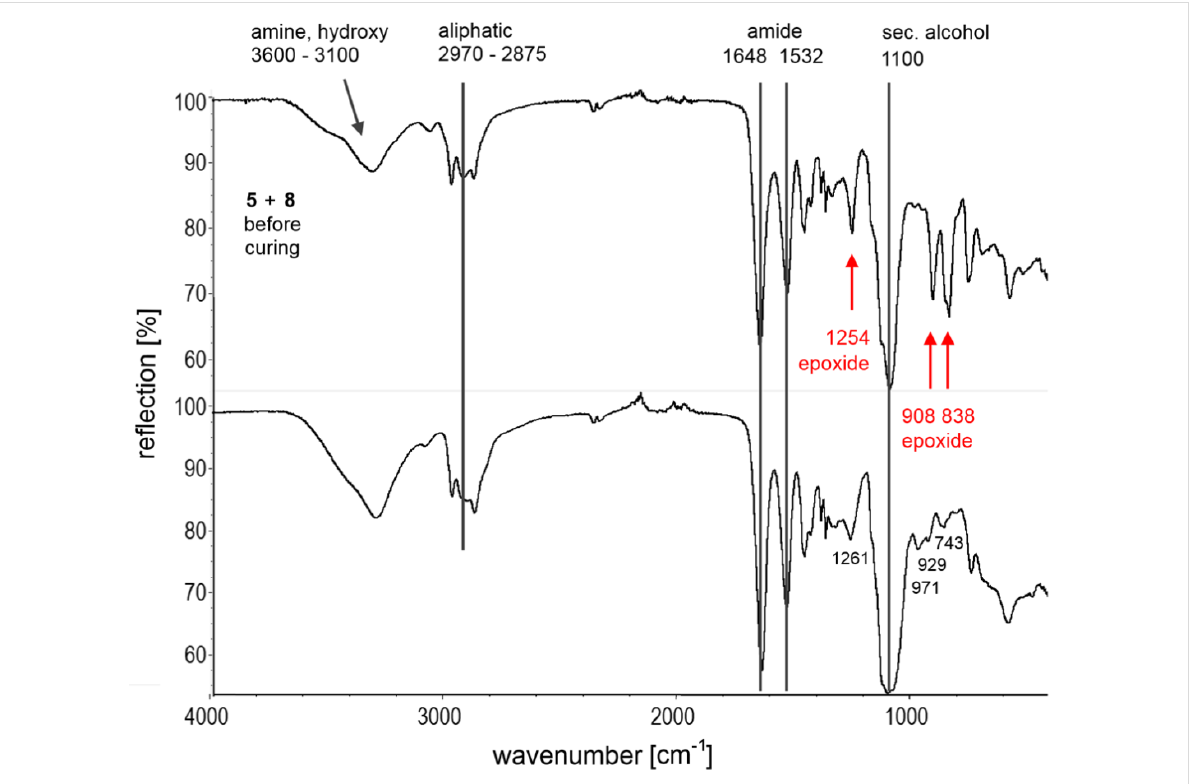
Figure 6: Comparison of the FTIR spectra of the monomer mixture of 5 and 8 and of the cured product 9 after 24 h.